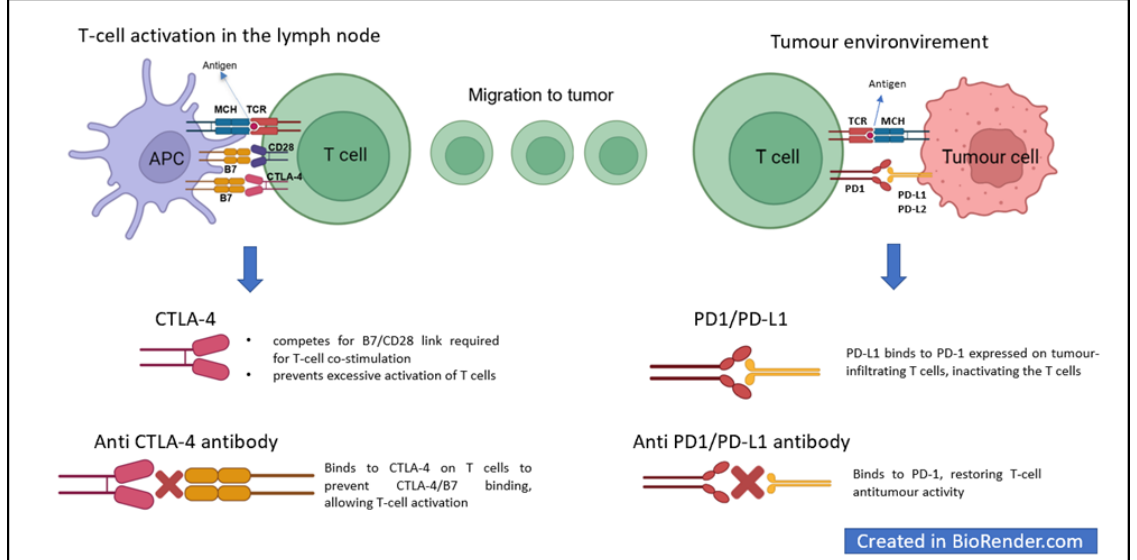
Figure 1. Immune checkpoint pathways and immune checkpoint inhibitors. Legend: APC, antigen- presenting cell; B7, B7 molecules; CD28, cluster of differentiation 28; CTLA-4, cytotoxic T-lymphocyte antigen-4; MHC, major histocompatibility complex; PD-1, programmed death protein 1; PD-L1, programmed death ligand 1; PD-L2, programmed death ligand 2; TCR, T-cell receptor.